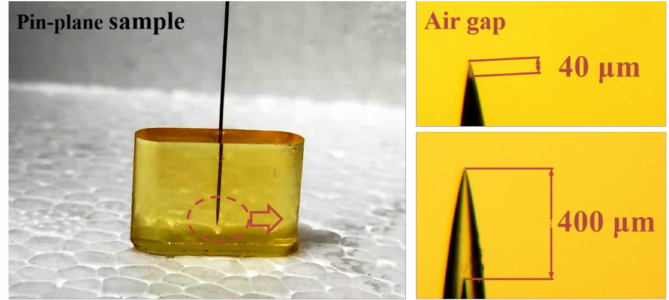
Figure 1. Picture of epoxy resin sample with needle and air